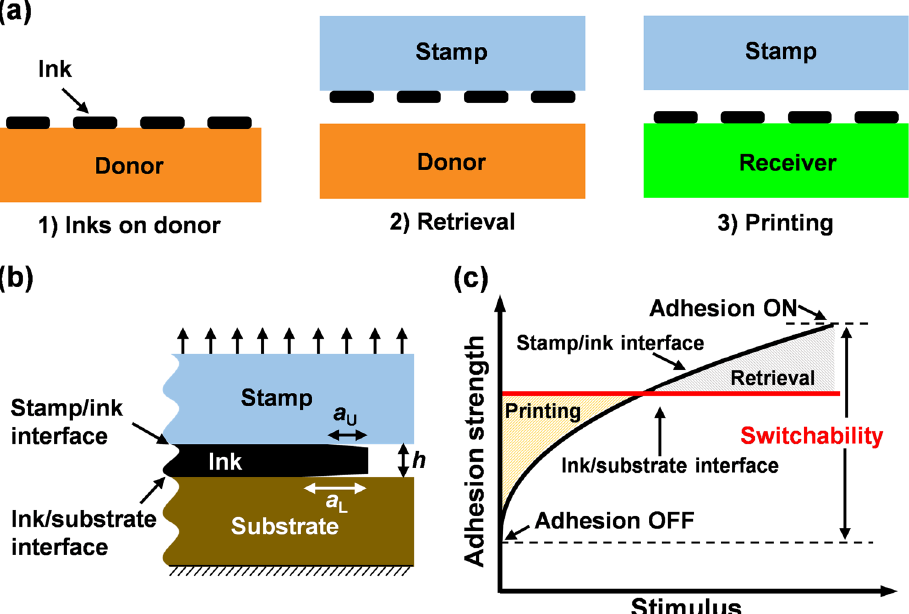
Fig. 2 Operating process and principles of transfer printing. a Illustration of the transfer printing process. ( 1 ) Inks are prepared on the donor substrate in a releasable manner. ( 2 ) Retrieval process: an elastomer stamp is used to retrieve the inks. ( 3 ) Printing process: inks are printed onto the receiver substrate. Adapted with permission from ref. 44 b The two interfaces in the stamp/ink/substrate structure. Adapted with permission from ref. 44 c Adhesion strength modulated by external stimulus, showing the high (ON) and low (OFF) adhesion state and